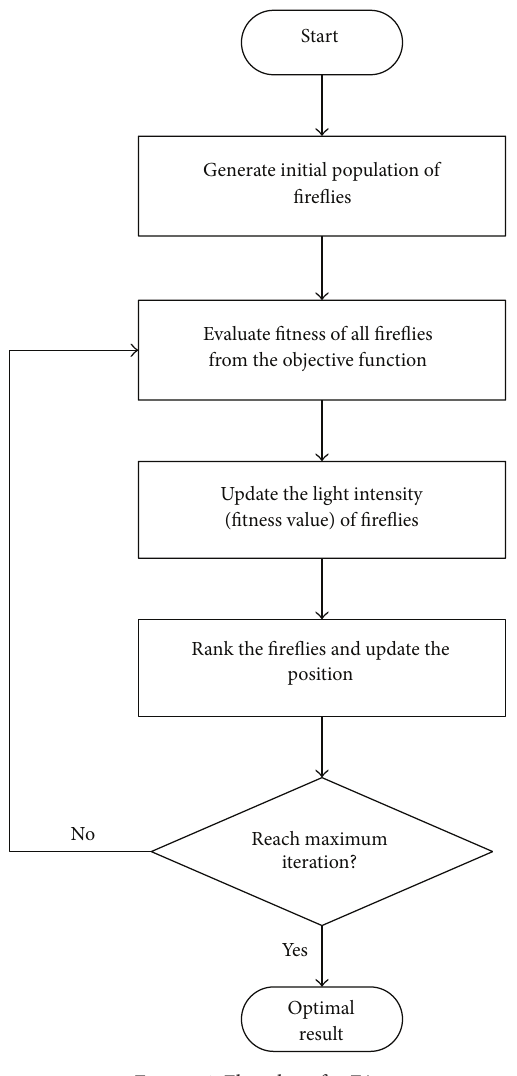
Figure 1: Flowchart for